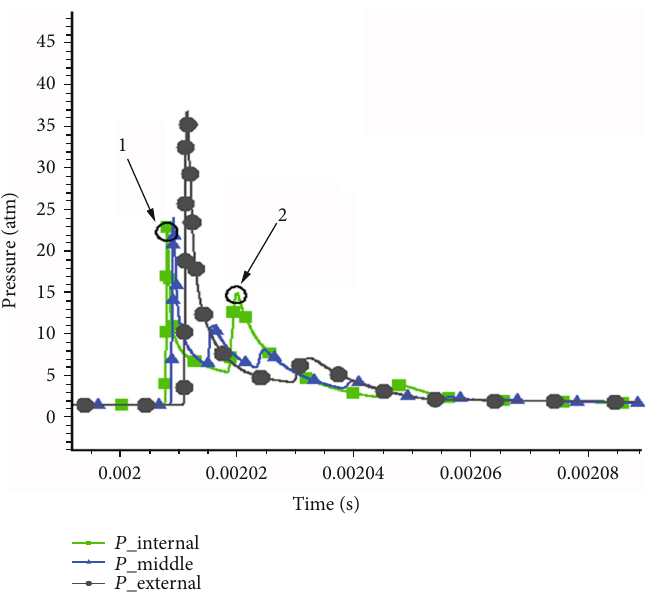
Figure 4: Pressures at the head.